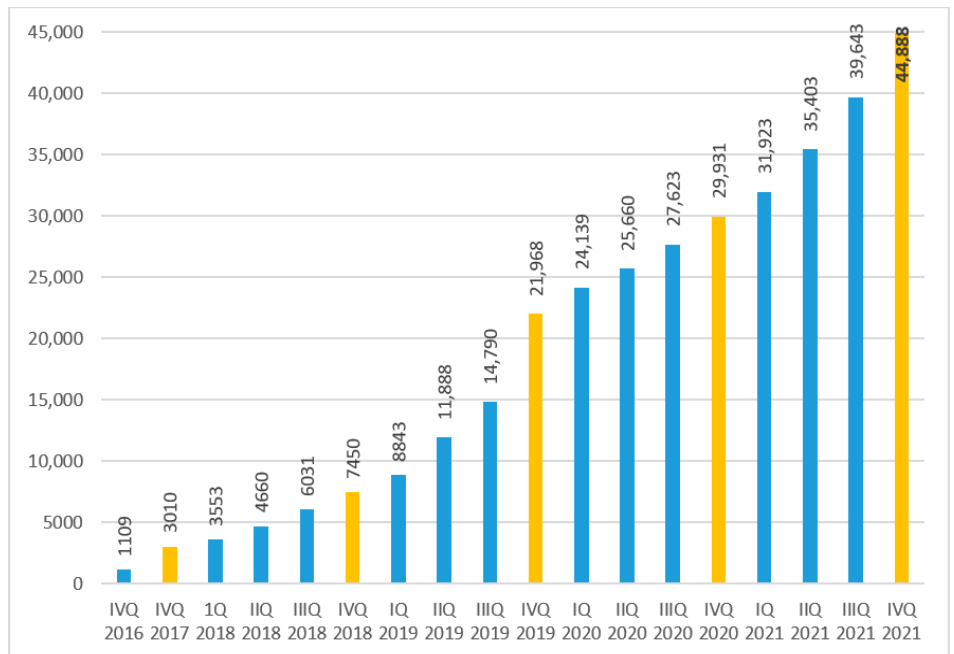
Figure 6. The number of solar power installations of households in Ukraine, units [43].